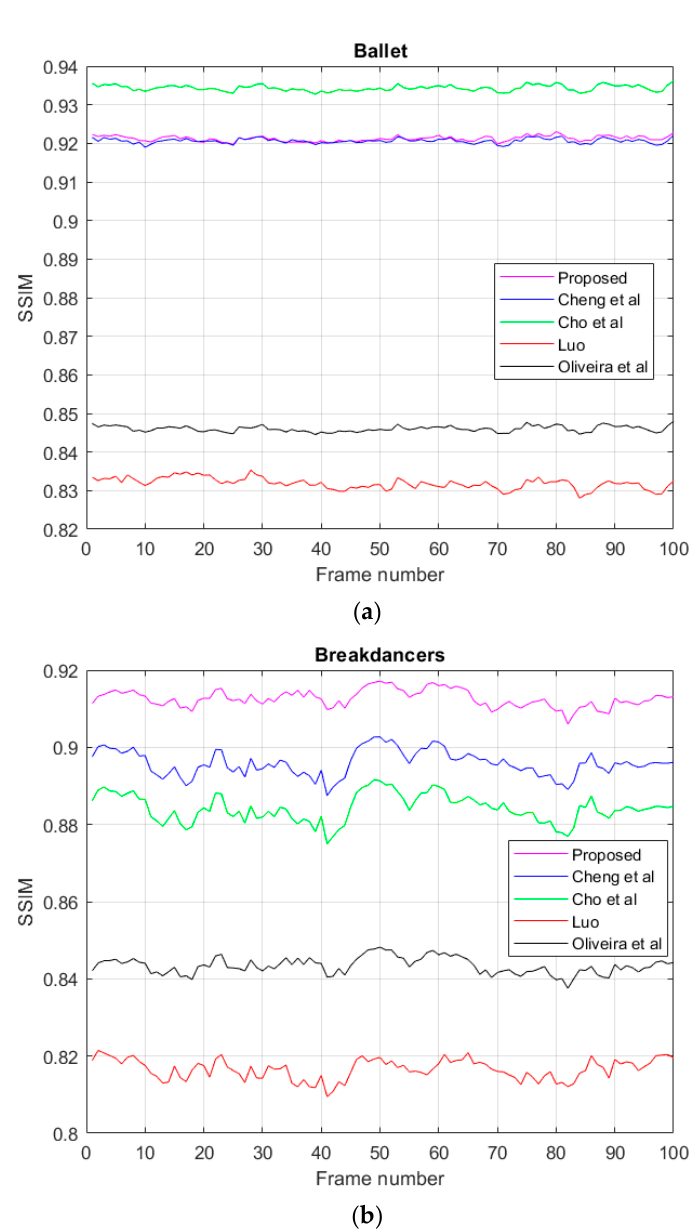
Figure 17. Comparative results of structural similarity (SSIM) value per frame. ( a ) Ballet dataset and ( b ) Breakdancers dataset.